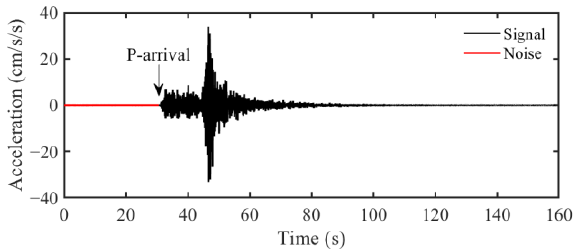
Figure 10. An example of recorded ground motion and noise (AKBAW--n.0212o88mof.BNE).